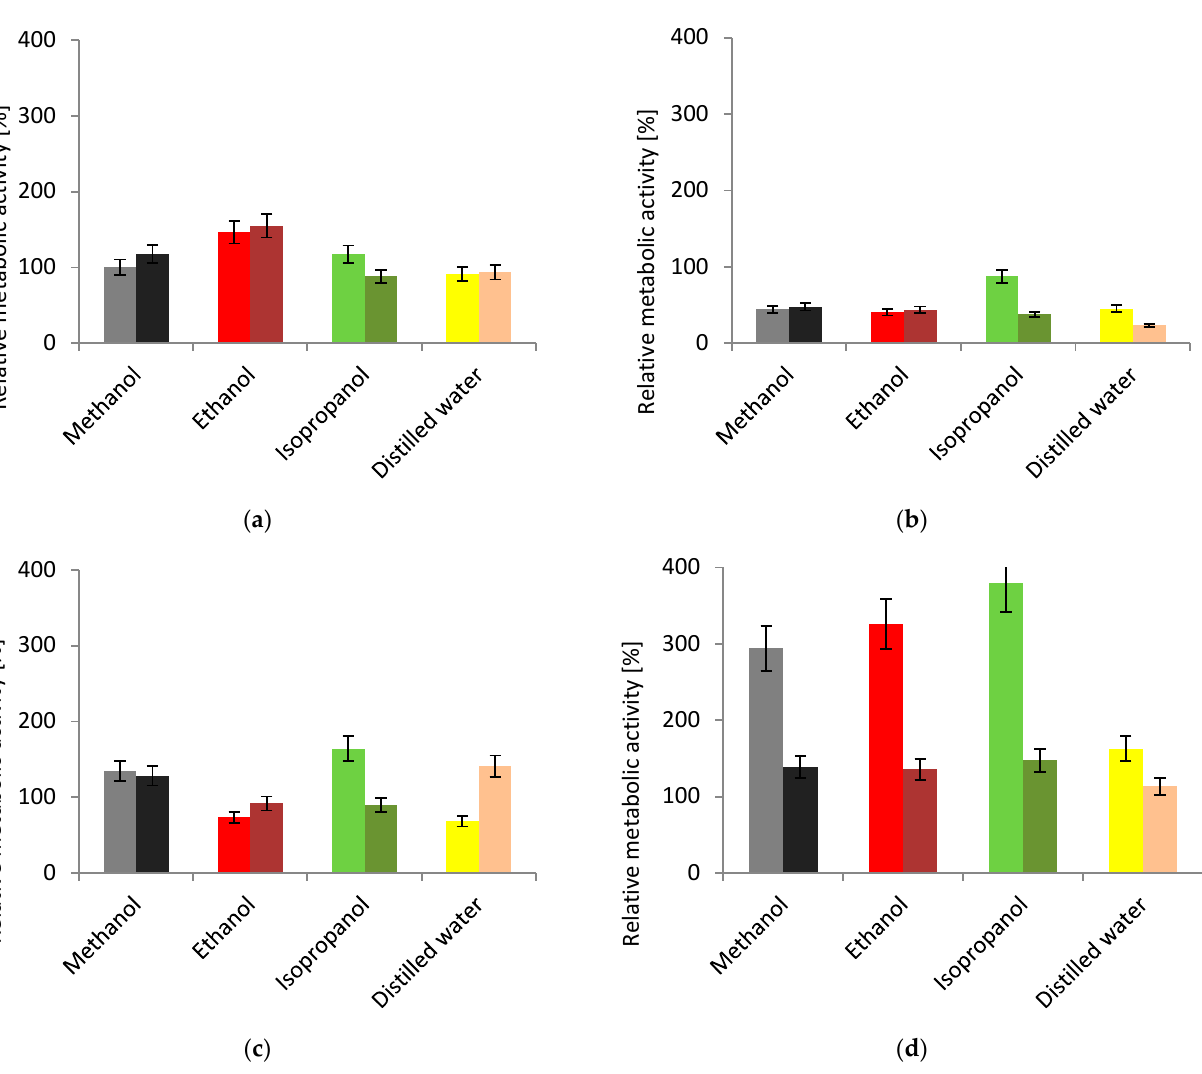
Figure 2. Cell viability assay; each pair of columns represents F. alnus Mill. extract concentrations: left, 0.5 g dm − 3 ; right, 0.1 g · dm − 3 ; ( a ) Pseudomonas putida ; ( b ) Pseudomonas fluorescens (ATCC 17400); ( c ) Pseudomonas fluorescens (environmental); ( d ) Lactobacillus rhamnosus .